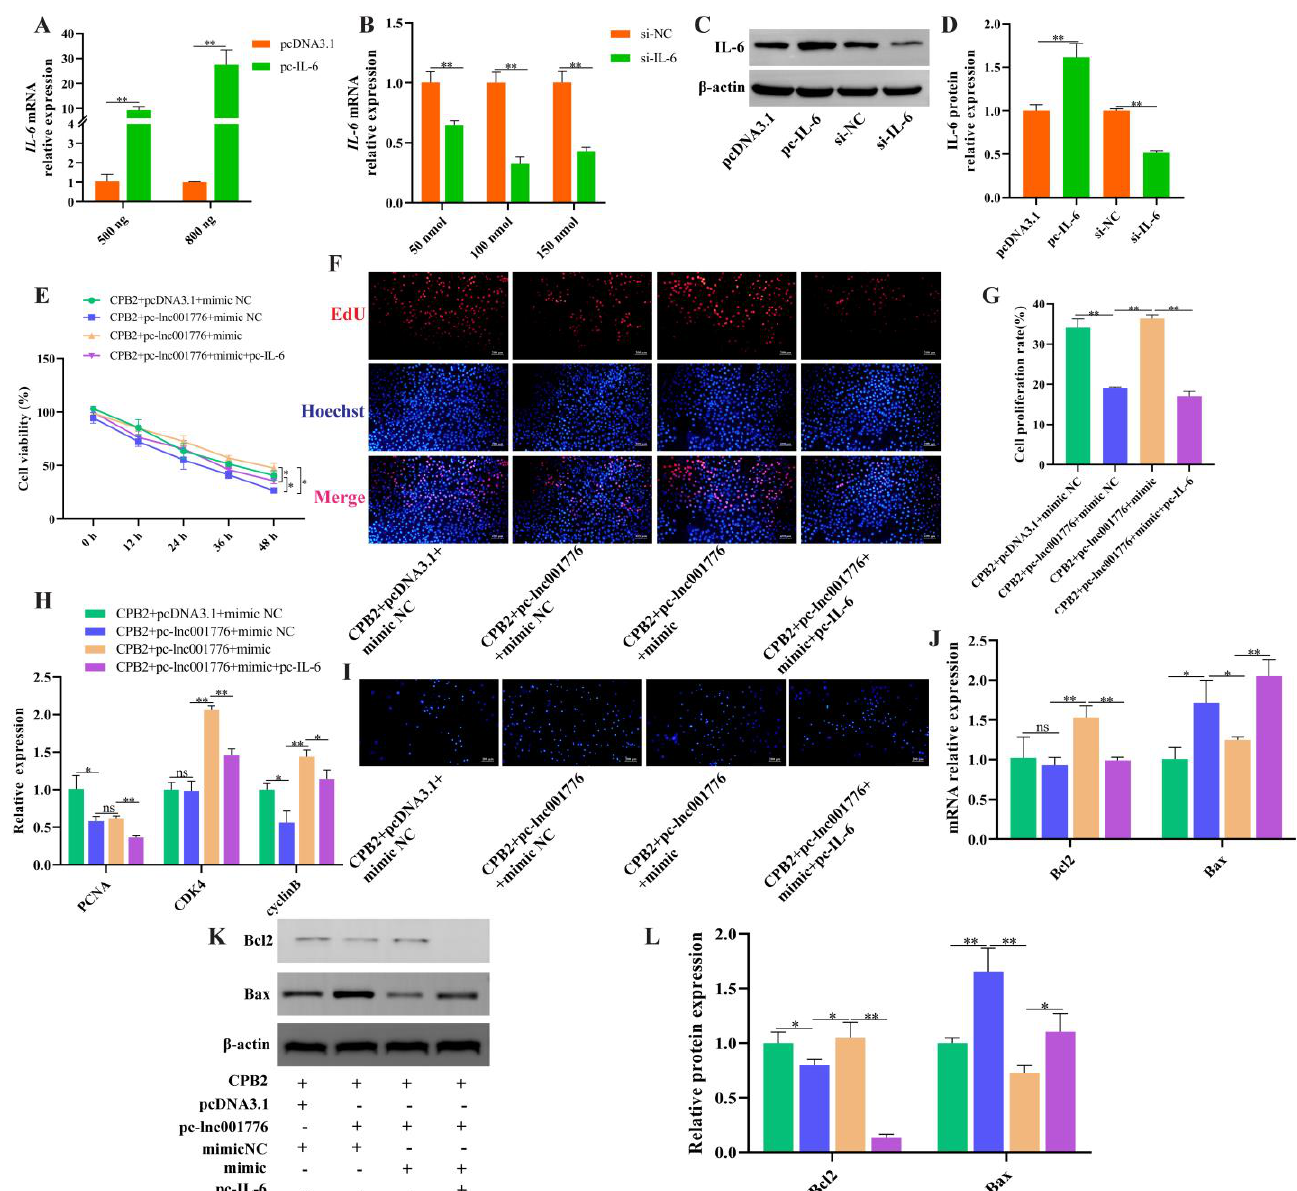
Figure 9. Overexpression of lnc001776 facilitated CPB2 toxin-induced apoptosis in IPEC-J2 cells by ssc-let-7i-5p/ IL-6 axis. ( A – D ) IL-6 overexpression and knockdown efficiency via RT-qPCR and Western blot. ( E ) Cell viability through CCK-8. ( F ) Cell proliferating by EdU staining. ( G ) Percentage of positive proliferating cells. ( H ) PCNA , CDK4 and cyclinB levels through RT-qPCR. ( I ) Cell apoptosis by Hoechst 33258 staining. ( J ) Bcl2 and Bax mRNA expression via RT-qPCR. ( K , L ) Bcl2 and Bax protein expression through Western blot. ns: not significant. * p < 0.05, ** p <